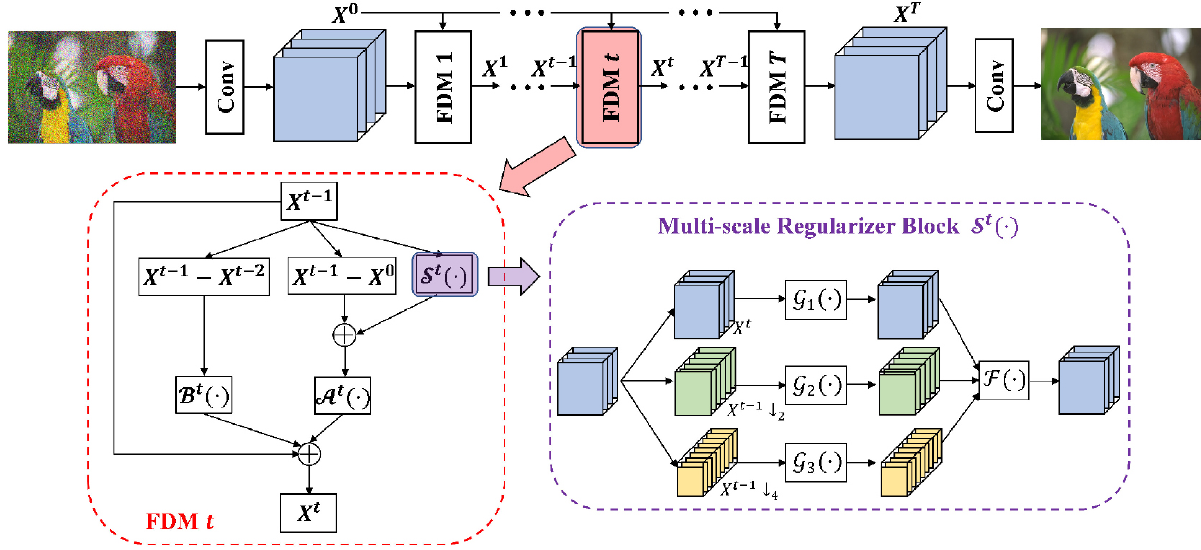
Fig. 2 Architecture of DUMRN. The first convolutional layer extracts feature X 0 from the noisy input, and then T feature-based denoising modules (FDMs) are stacked to remove noise in deep feature space; the structure of FDM is based on the momentum gradient descent algorithm. Benefiting from FDM, there is no need to transform deep features into image space at each step. The last convolutional layer converts the denoised feature X T to a clean image. A multi-scale regularizer block S ( · ) learns deep prior information from features at different resolutions; ↓ k represents down-sampling with a scaling factor of k